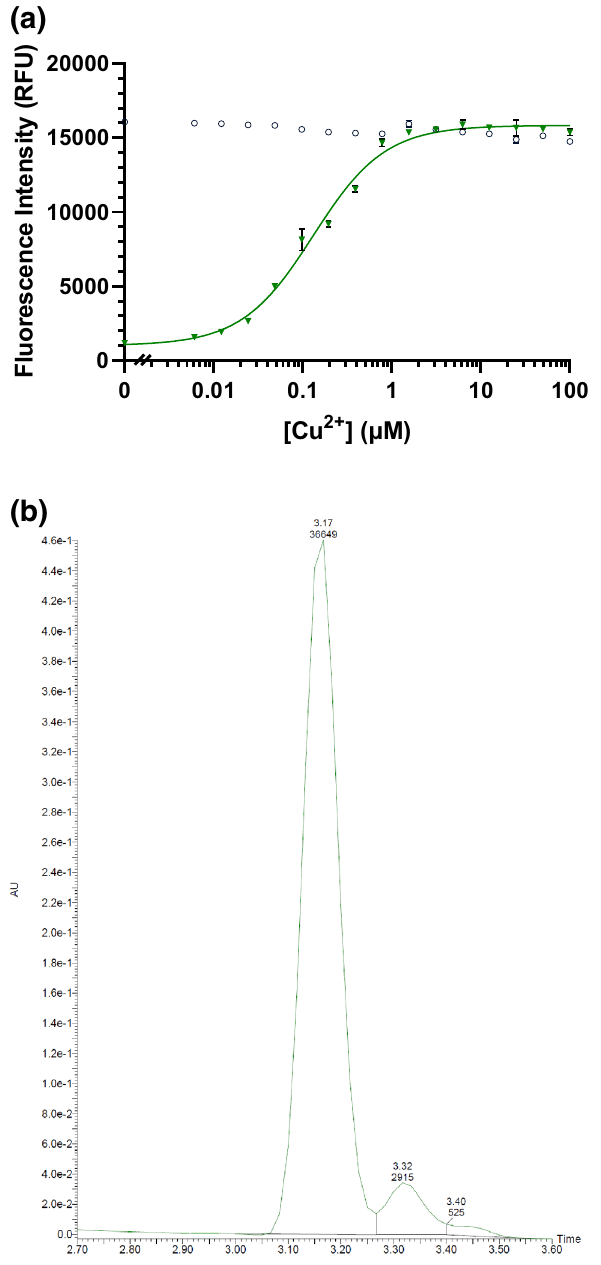
Figure 8. Inhibition of thiaminase I-mediated thiamine degradation in the presence of CuCl 2 ( a ) Fluorescence intensity measurements made in the presence of 10 µM thiamine, 1 mM pyridoxine, and Cu 2+ (6 nM–100 µM) in the presence (green triangles) and absence of 0.33 µg/mL thiaminase I (empty black circles) at 37 °C for 1 h. 5 µL of the reaction mixture was diluted with 45 µL water, then 100 µL potassium ferricyanide in 15% (w/v) sodium hydroxide was added prior to measurement using 360/40 nm excitation, 450/50 nm emission. Each point is the average of the fluorescence values in triplicate with min. and max. values represented by the error bars. A 4-parameter logistic equation was used to fit the data (dotted line) from the thiaminase incubations. ( b ) Chromatogram showing the lack of formation of the pyridoxine-pyrimidine adduct at 3.45 min and loss of thiamine (3.30 min) under conditions in ( a ) in the presence of 100 µM Cu 2+ . ( c ) The kinetics of thiamine degradation using endpoint fluorescence intensity measurements at ascorbic acid concentrations ranging from 0 to 12.5 µM from 15 min to 4 h. ( d ) Effect of time on the IC 50 for ascorbic acid and Cu 2+